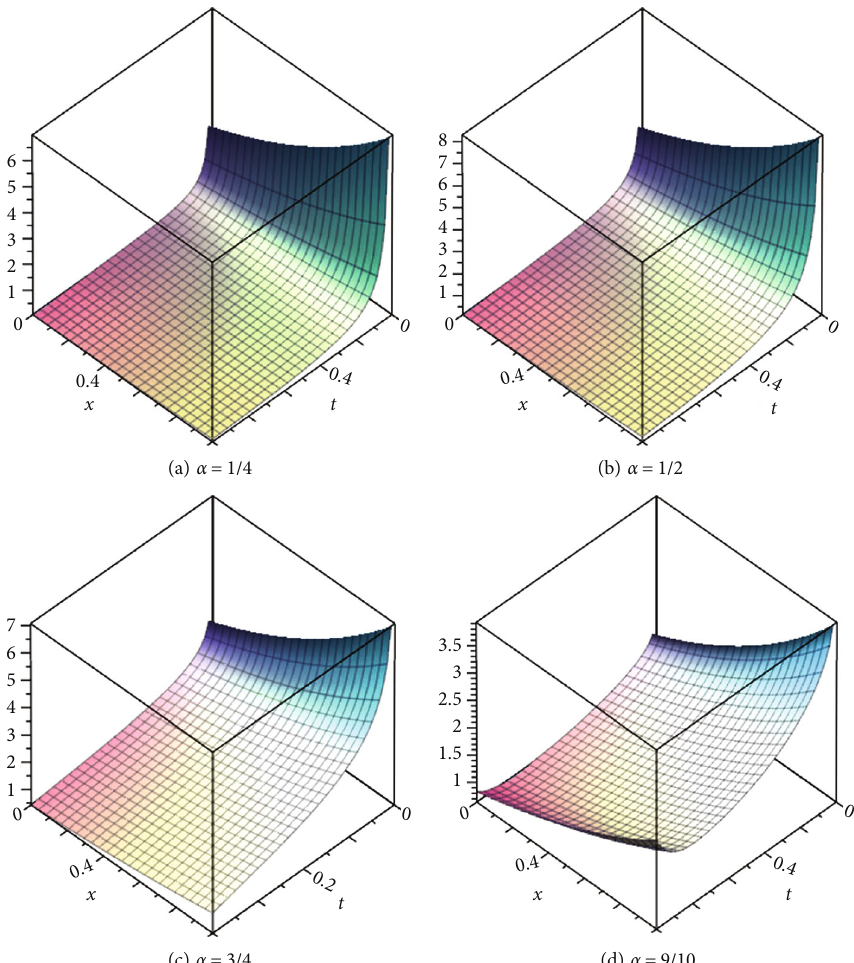
= a = b = λ = 1 and for α = 0 : 25,0 : 5,0, 75,0 : 9 2